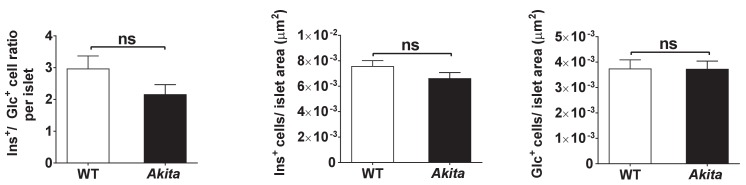
Islet composition of wild-type and Akita mice.β/α cell ratio and number of β and α cells per islet area in P19-21 wild-type and Akita mice (n = 44 and 35 islets isolated from three to four mice in each group).